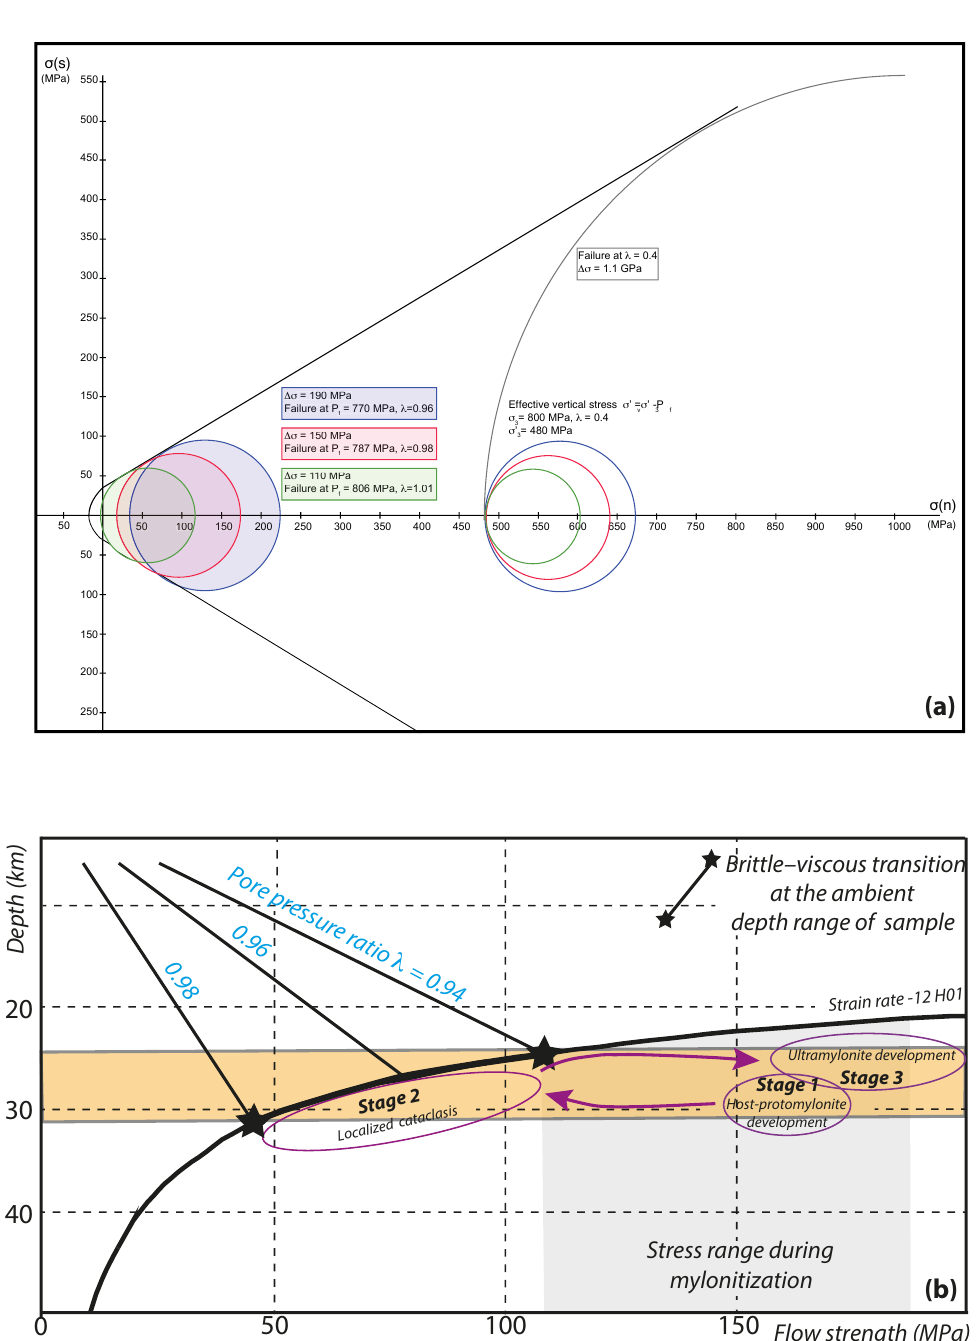
Figure 11. (a) Brittle failure analysis for our studied sample; see text for assumptions and approximations. For the differential stress range and the vertical stress considered, brittle failure requires (sub)lithostathic fluid pressure (0 . 96 <λ< 1), whereas viscous deformation at the estimated depth range (23–30km) is only possible for pore fluid pressure ≤ 0.94. (b) Rheological profile calculated for a fixed strain rate of 10 − 12 s − 1 (see text for calculation details) using the quartz flow law of Hirth et al. (2001). A cycle of switching in deformation style and mechanisms is suggested for the analysed sample in its ambient depth range. The frictional Byerlee envelope is calculated using an average friction coefficient of 0.7 for various pore fluid pressure ratio values (Fig. 11a and text). Stress estimates based on recrystallized quartz piezometry (grey shaded area) were calculated following Stipp and Tullis